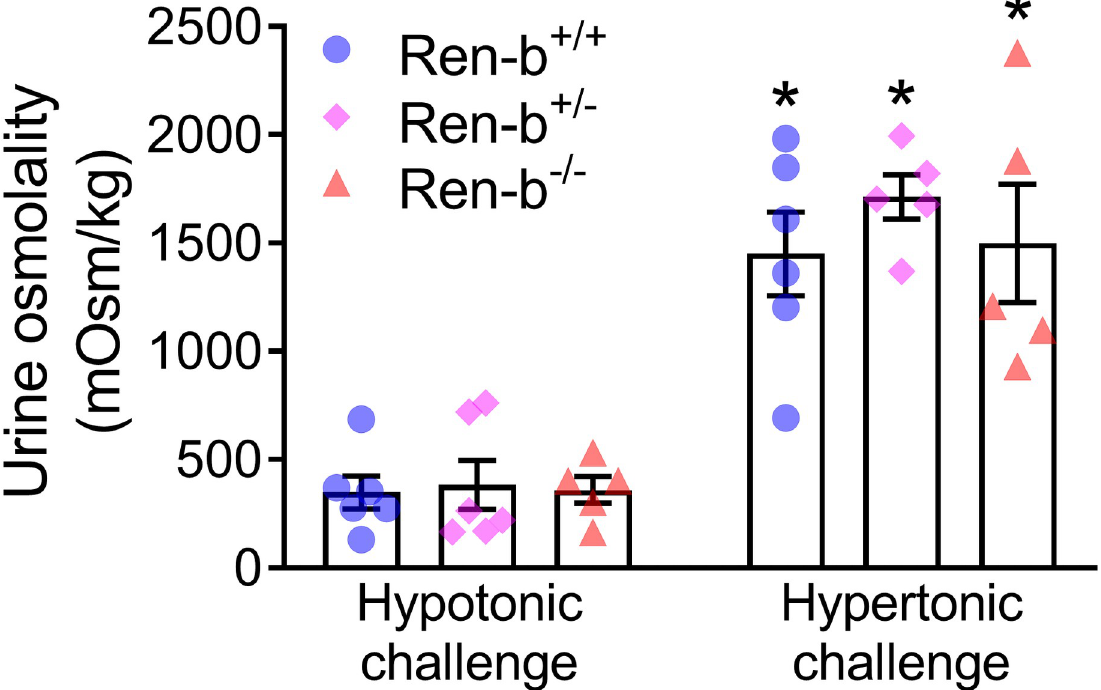
Fig 4. Renal function. Urine concentrating capacity was assessed in male and female wildtype (Ren-b +/+ ), heterozygous Ren-b knockout (Ren-b +/- ) and homozygous Ren-b knockout mice (Ren-b -/- ). Urine was first collected for 60 minutes post-hypotonic saline challenge (500 microliters of 0.03 mol/L NaCl; intraperitoneal). Subsequently, the same procedure was performed for a hypertonic saline challenge (500 microliters of 0.3 mol/L NaCl; intraperitoneal). � p < 0.05 vs same genetic group on hypotonic challenge.